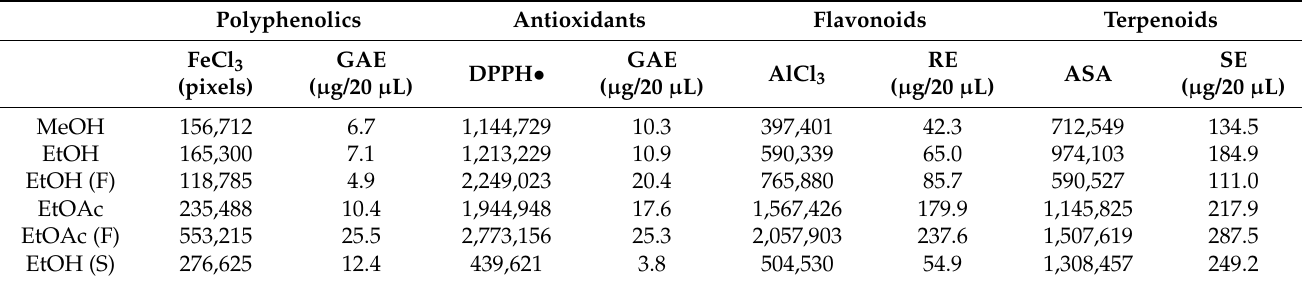
Table 2. Antioxidant activity, total phenolics, total flavonoids, and total terpenoids in